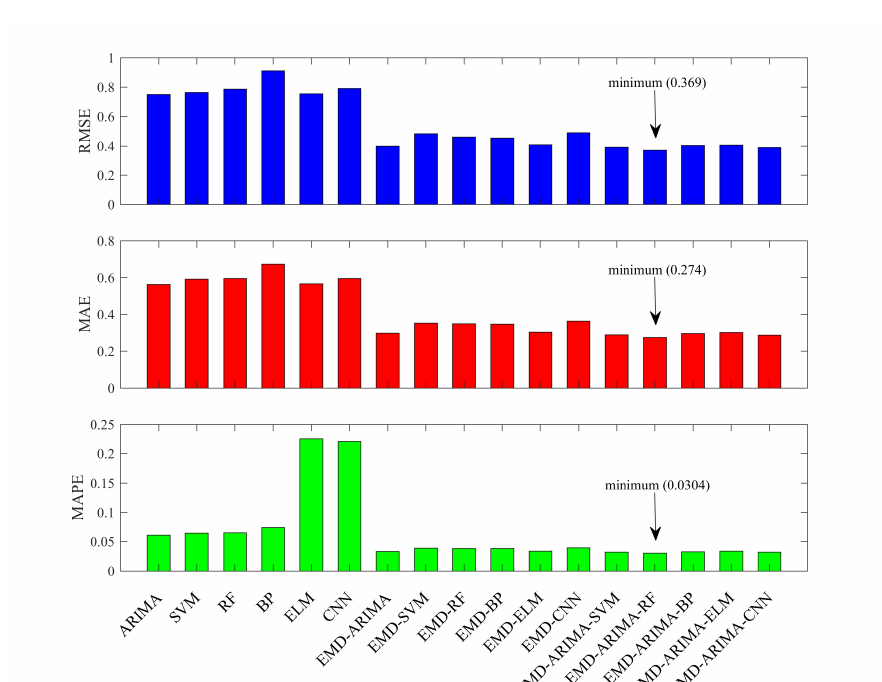
Figure 9. Wind speed prediction comparisons for the 10 min data at the HLJ